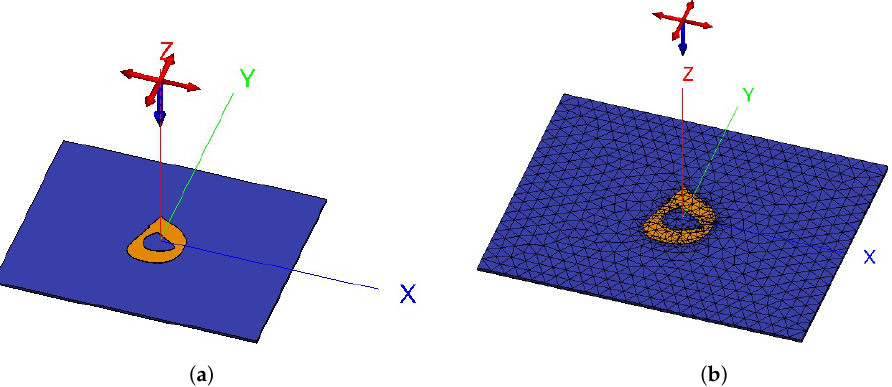
Figure 7. Numerical model of realized letter haa ( Ł ) model using MoM technique ( a ) without mesh; ( b ) with mesh.